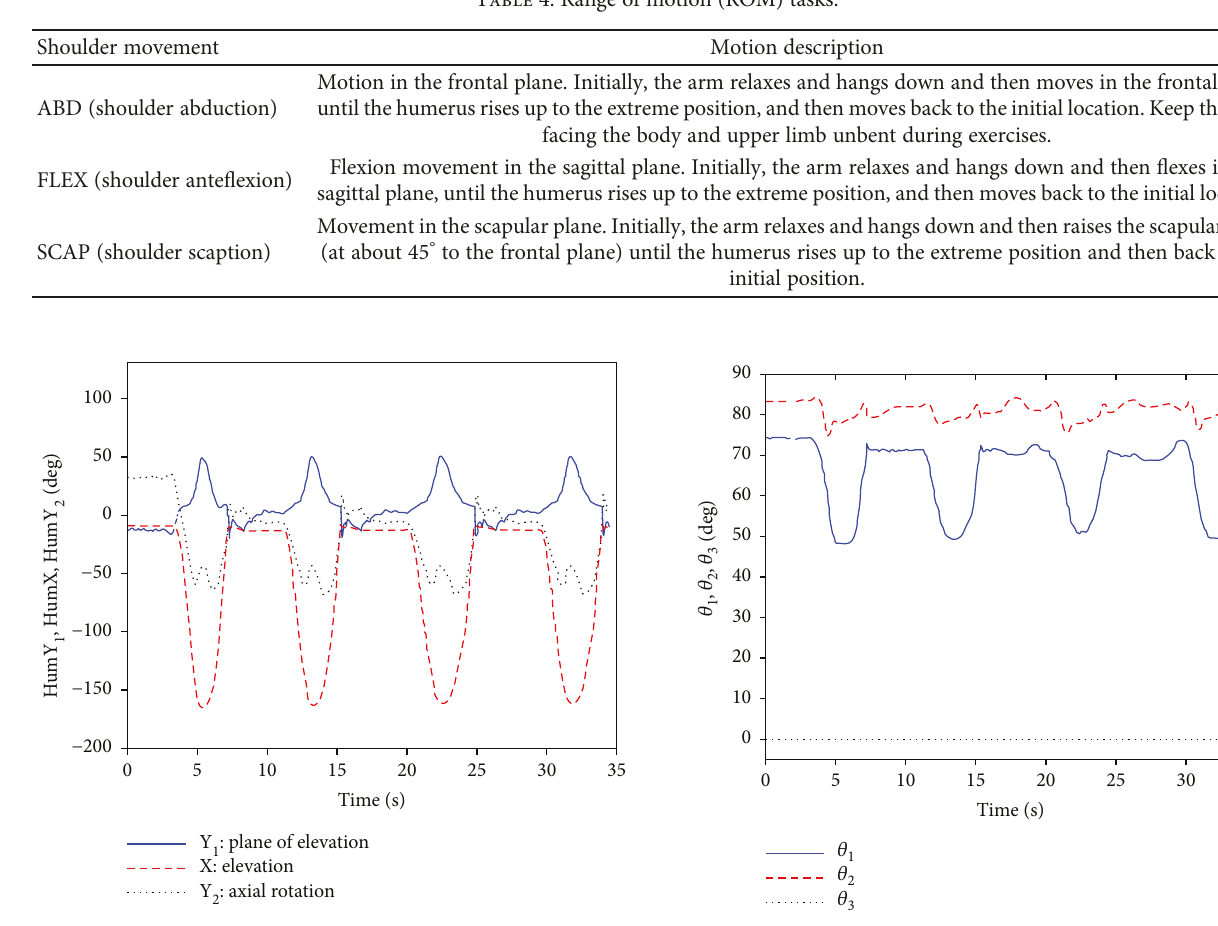
Figure 6: Movement posture of the humerus (ABD).